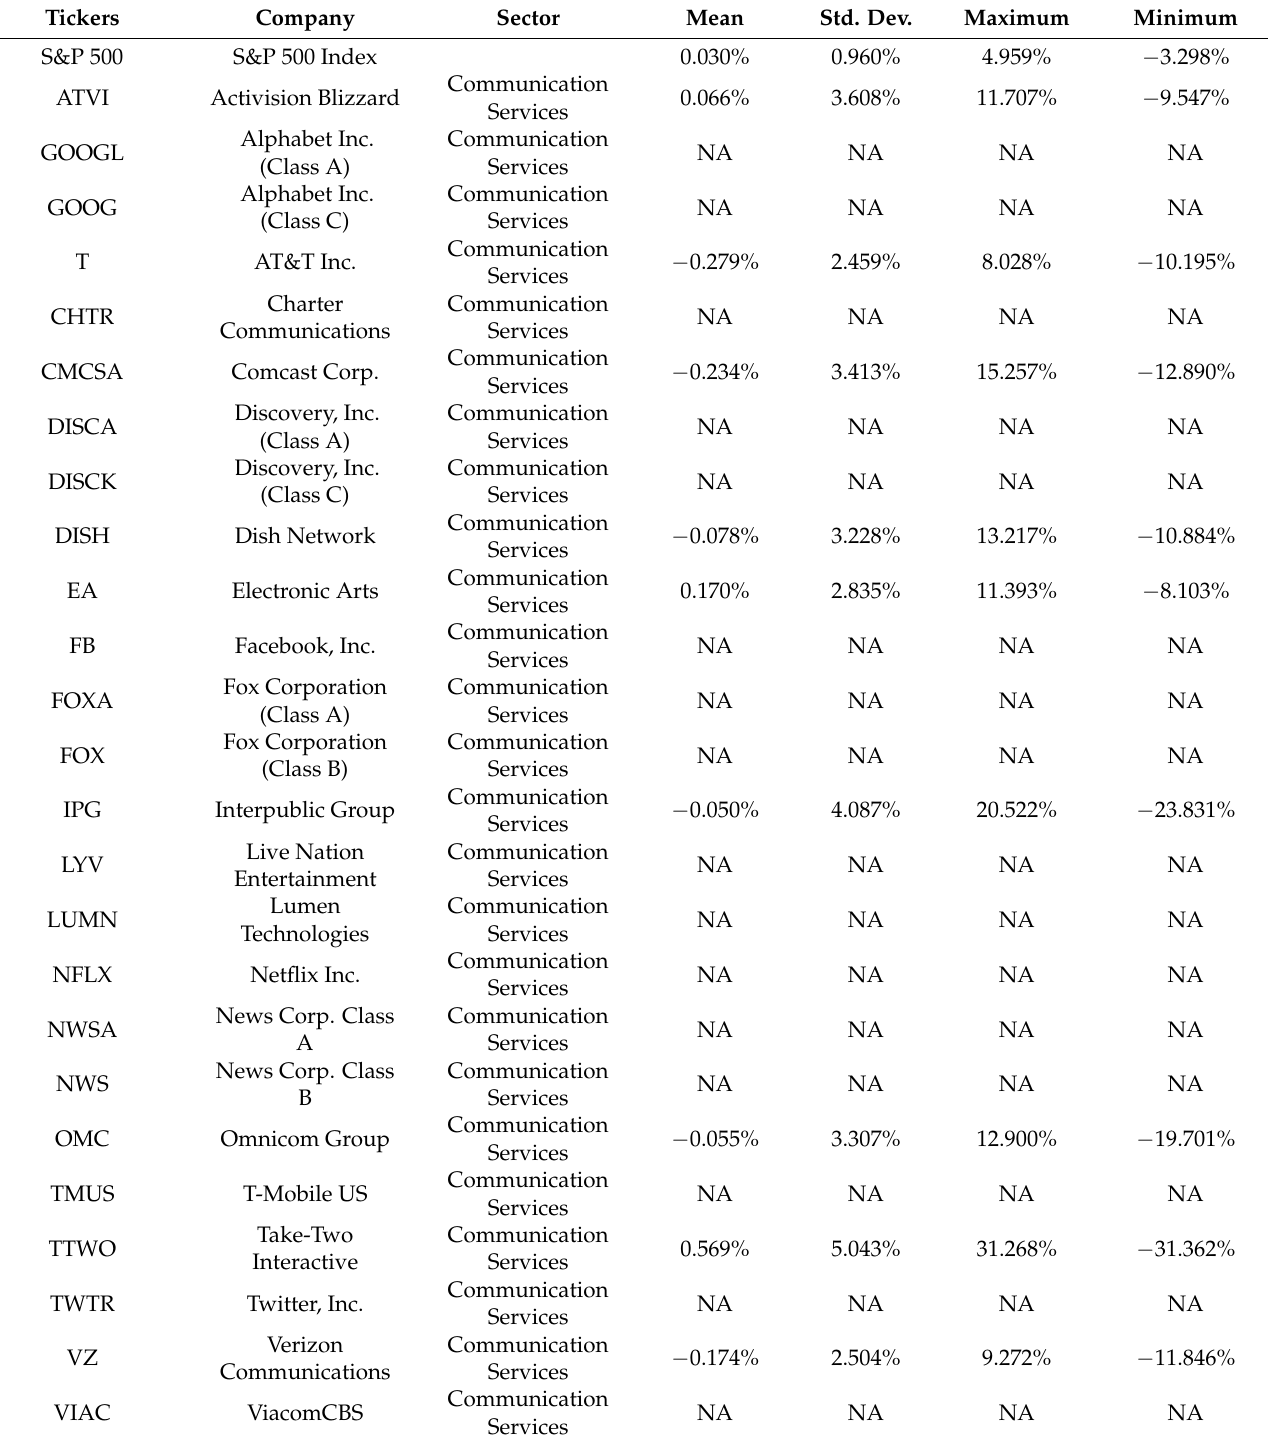
Table A1. Table of Descriptive Statistics for the normal returns of the 3 sectors (“Moscow theater hostage crisis” Geopolitical event) and event window ( −